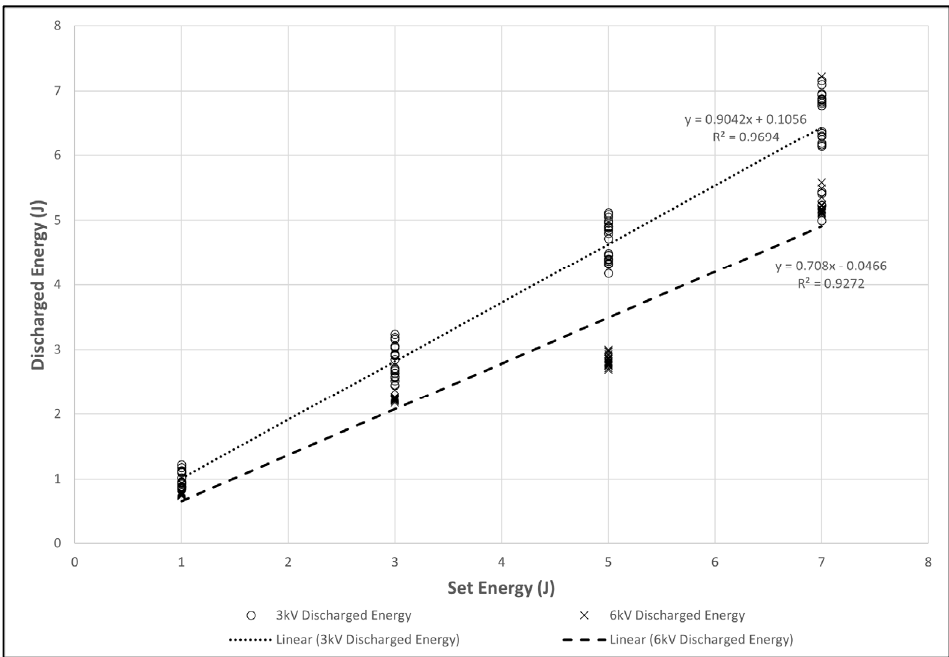
Figure 6. Scatterplot of equipment set energy versus actual discharged energy by voltage applied to Lolium multiflorum.